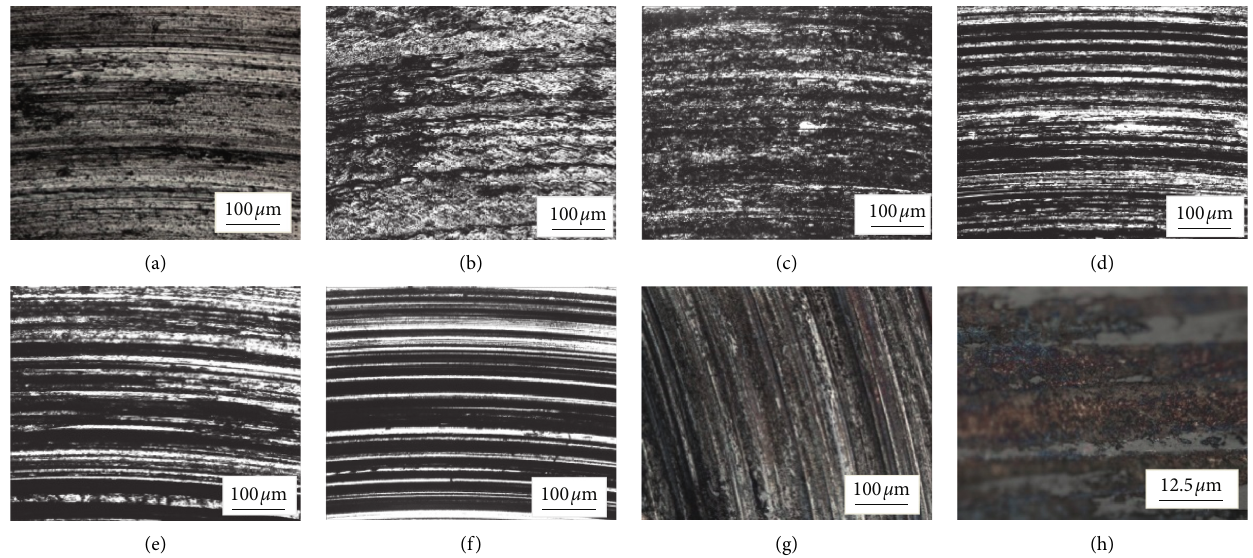
Figure 10: Worn morphologies of the S0 cladding at different temperatures: (a) room temperature; (b) 200 ° C; (c) 300 ° C; (d) 400 ° C; (e) 500 ° C; (f) 600 ° C; (g) 700 ° C; (h) 700 ° C with high magnification.